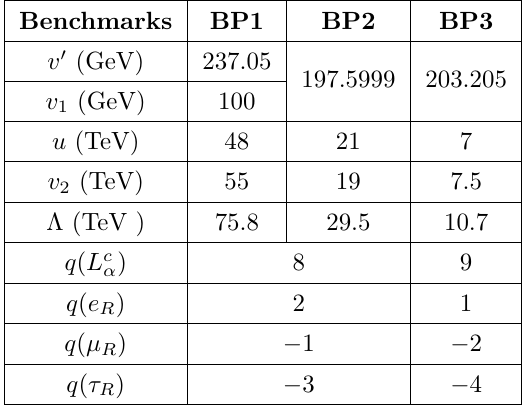
Table 3 . The numerical values of vacuum expectation values and FN charge assignments of leptons for our